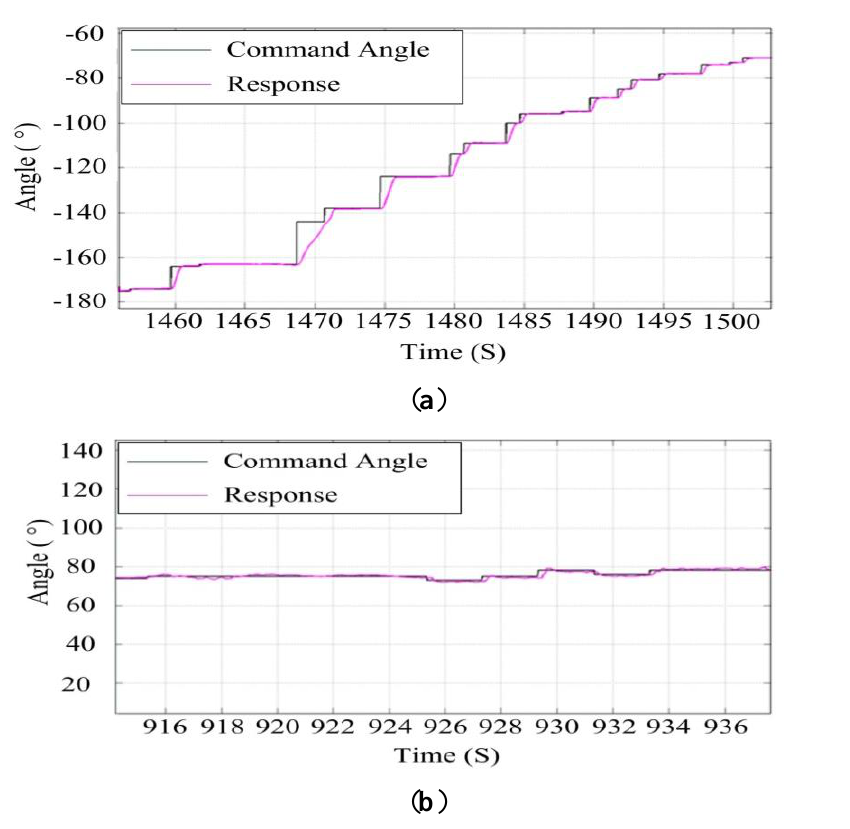
Figure 22. The tracking results of the ISP in the experiments on a real UA in the air: ( a ) the azimuth gimbal; ( b ) the pitch